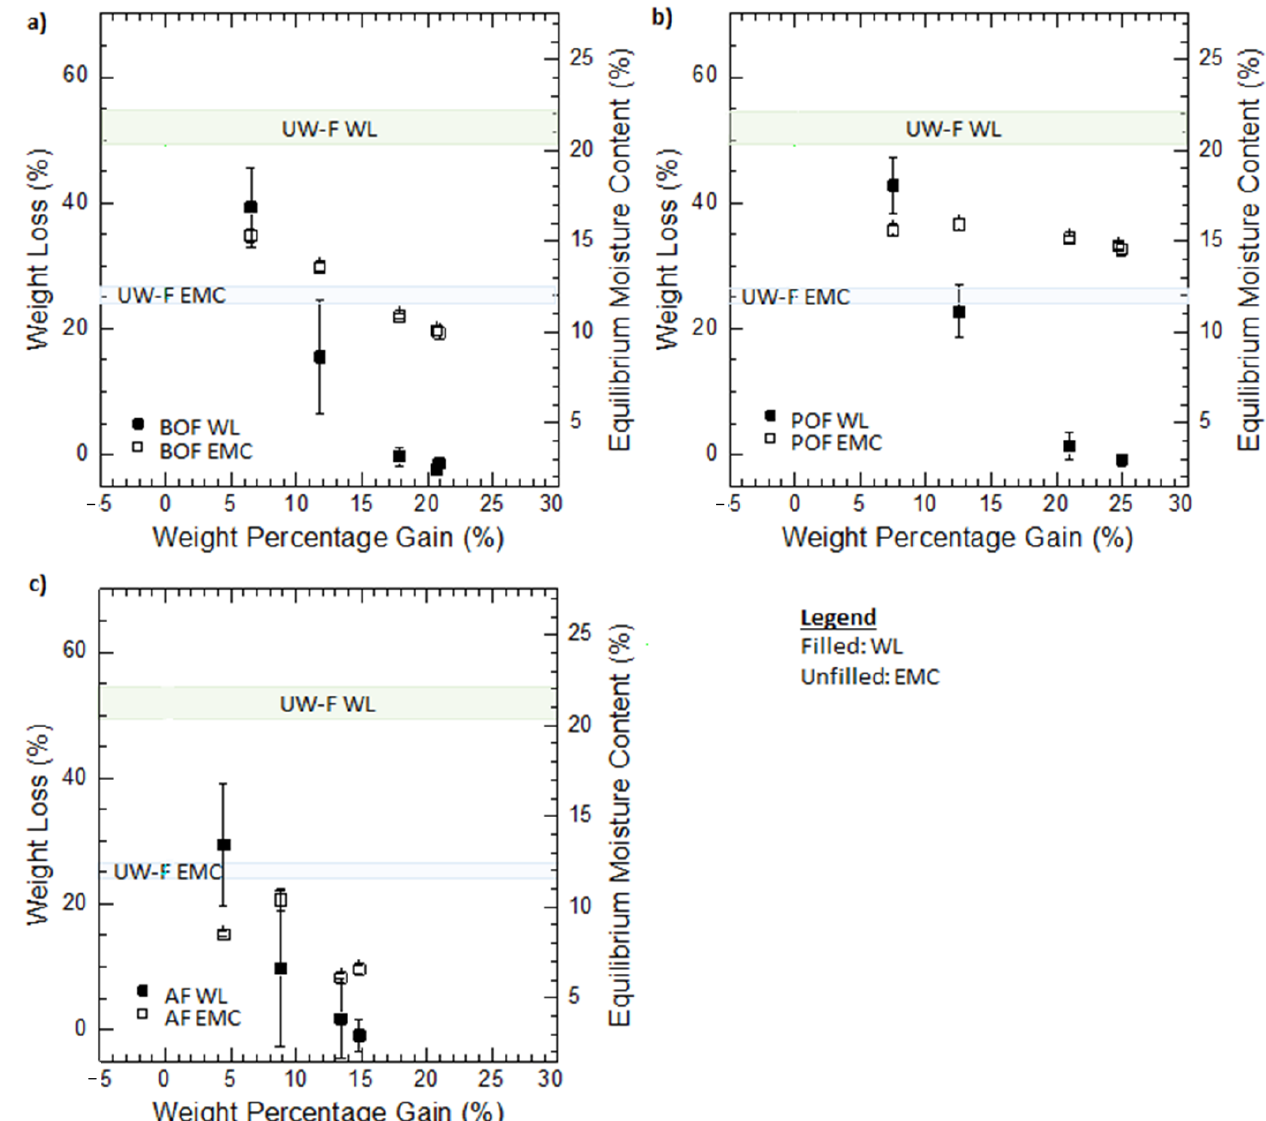
Figure 1. Effects of two different alkylene oxides and one anhydride modification on the weight loss (WL, left-y axis) and equilibrium moisture content (EMC, y-right axis) at 90% RH and 27 °C for wood fibers modified with ( a ) butylene oxide (BOF), and ( b ) propylene oxide (POF), ( c ) acetic anhydride (AF). EMC measurements were performed with six replicates, WPG were calculated from triplicates, and WL measurements had 5 replicates. Data points correspond to the mean values and the error bars are the standard deviations.